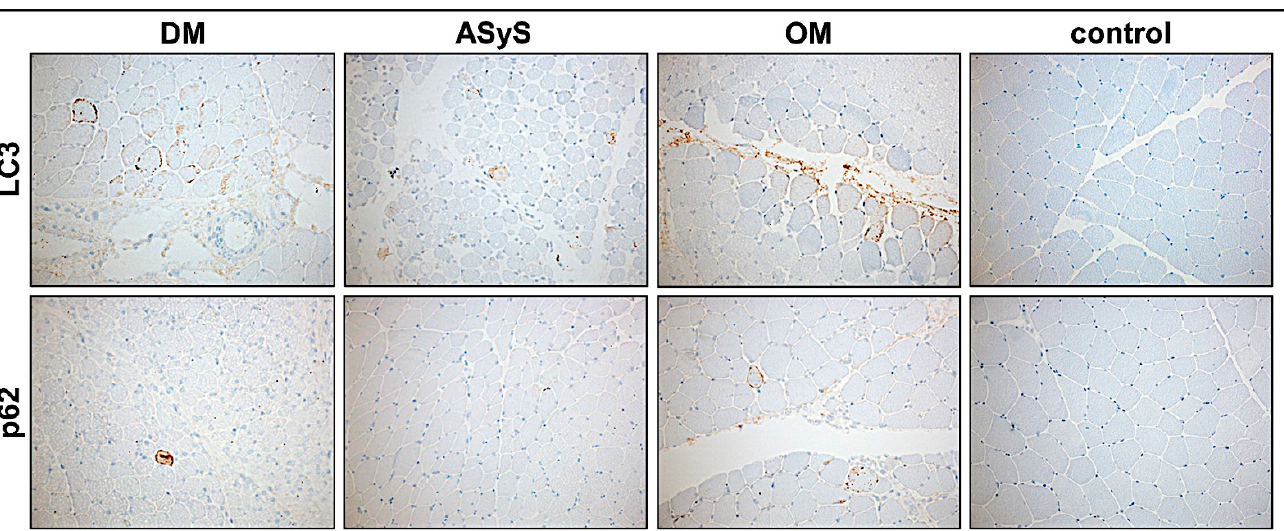
Figure 7. MxA upregulation and tubuloreticular inclusions in muscle biopsies from patients with IIM. Strong perifascicular upregulation of interferon surrogate marker MxA in DM (P4) and anti- Jo-1 ASyS (P14) associated with tubuloreticular inclusions (TIR) in the endothelial cells of small ves- sels. Weak MxA upregulation on scattered myofibers with nonspecific osmiophilic inclusions in anti-PL7 ASyS (P6) and OM (P3) (magnification 20×)) (DM = dermatomyositis; ASyS = antisynthe- tase syndrome; OM = overlap myositis).